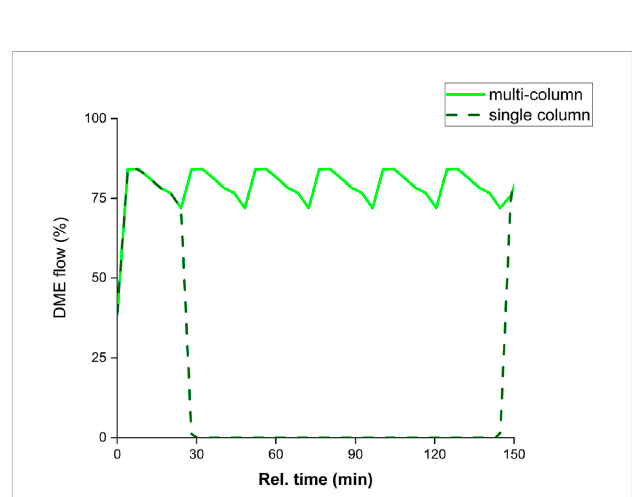
Continuous DME outlet fl ow (after N 2 fl ush) for the multi-column system and a single column, normalized with respect to the inlet carbon fl ow (carbon